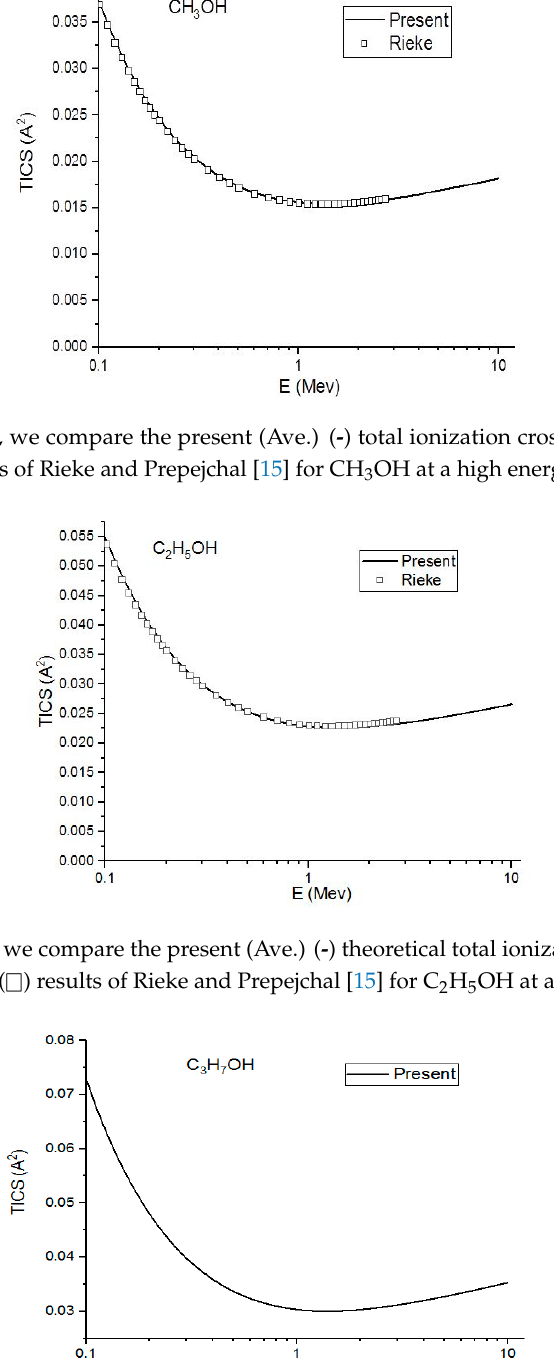
Figure 6. In this figure, we plot the present (Ave.) total ionization cross sections (TICS) in A 2 v / s a high energy range for C 3 H 7